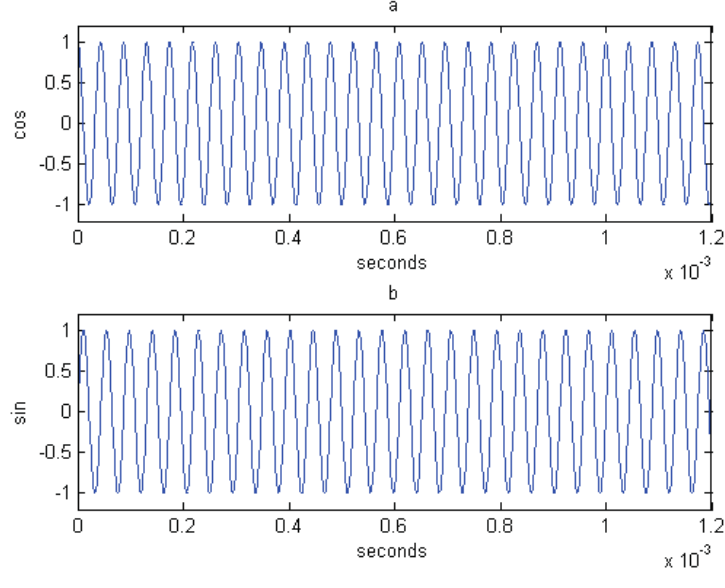
Figure 17. Simulation result of